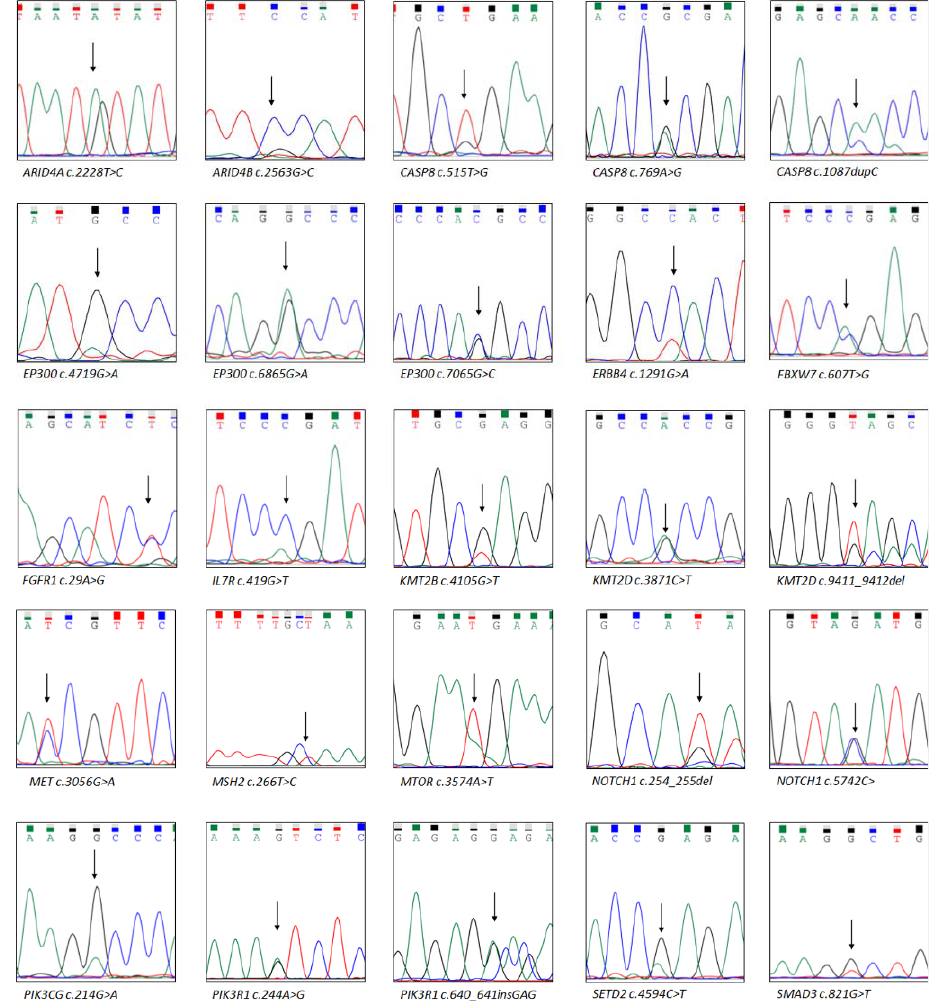
Figure 1. Driver gene mutations confirmed using Sanger sequencing. Next-generation sequencing data provided these driver gene mutations. The arrow indicates the location of the mutation.